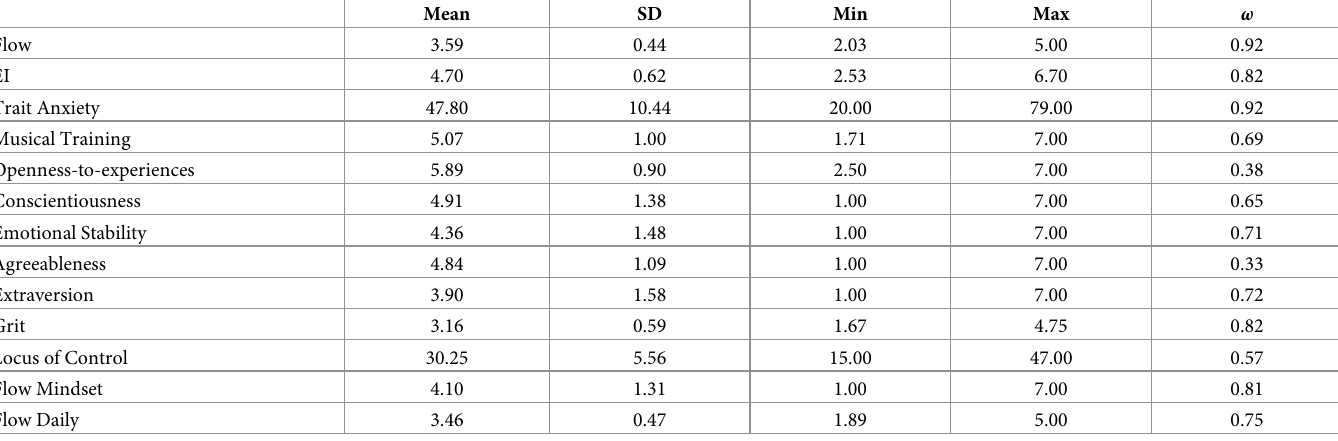
Table 2. Descriptive statistics of all main variables; flow in music, emotional intelligence, trait anxiety, musical training (subscale 3 of Gold-MSI), Big Five personal- ity traits, grit, locus of control and flow mindset and flow in daily